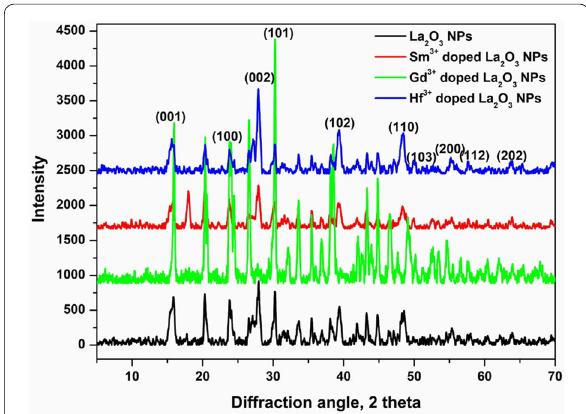
Fig. 4 X-ray diffraction patterns for doped and undoped La 2 O 3